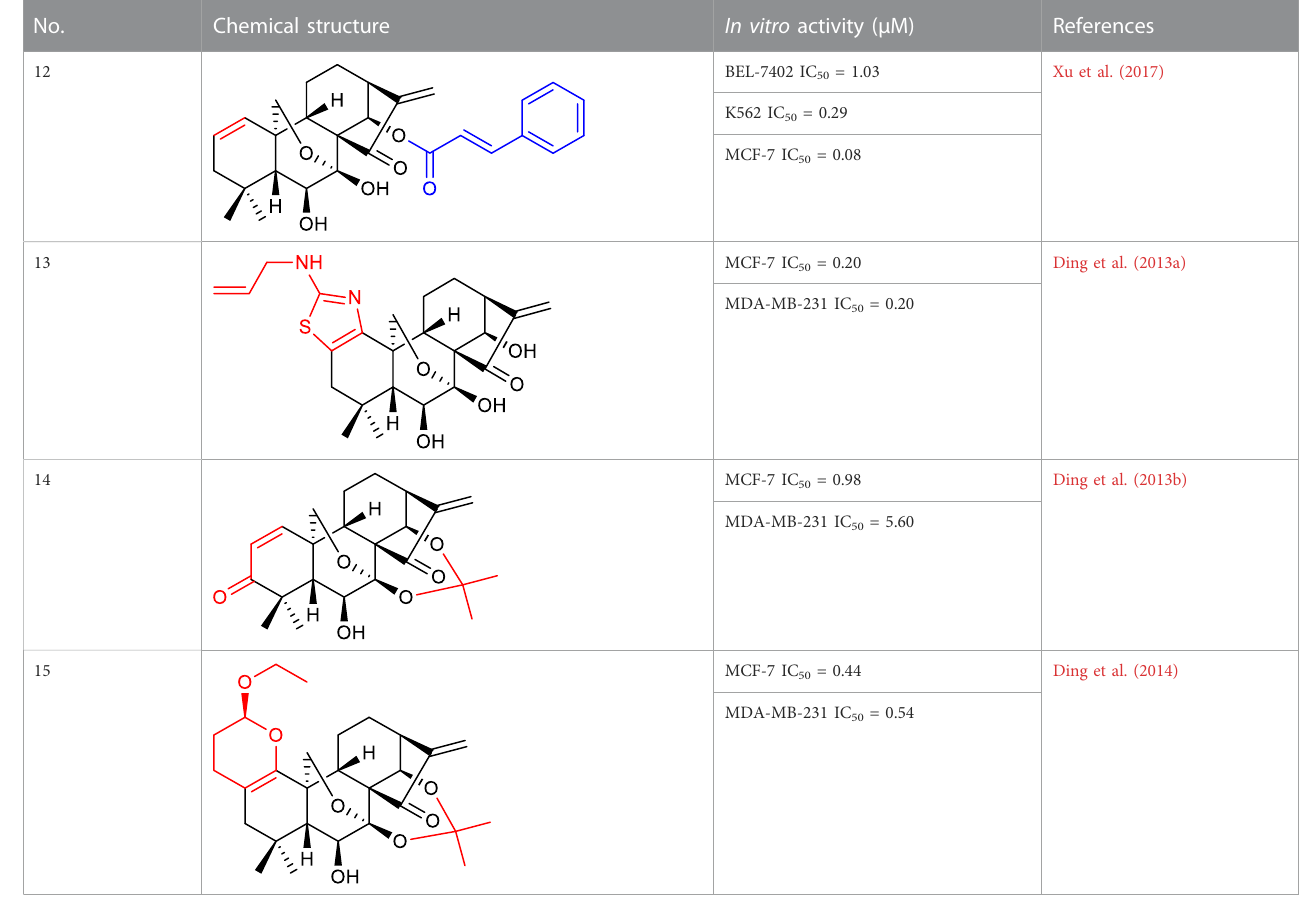
TABLE 2 Recent approaches of oridonin optimizations (modi fi cations of A-ring).